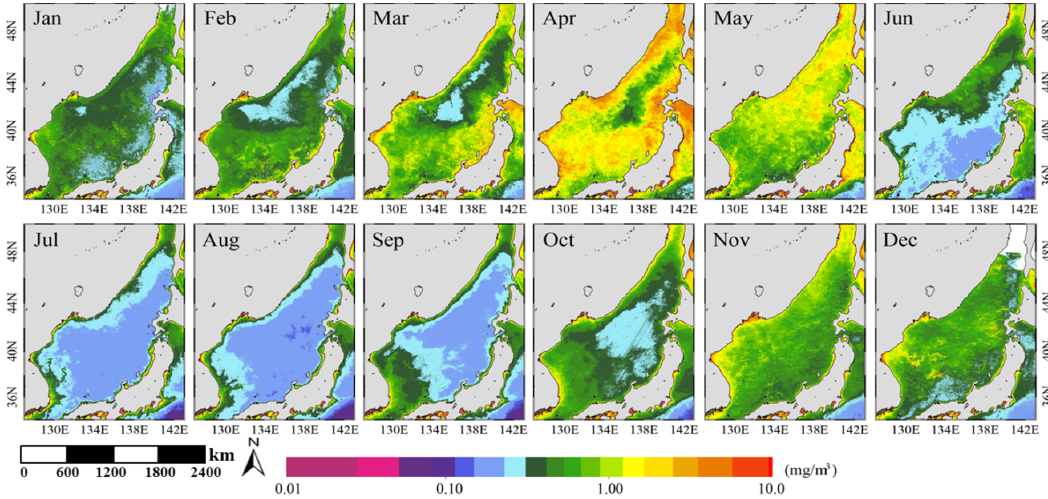
Figure 3. Climatological monthly Chl-a maps in the East Sea.